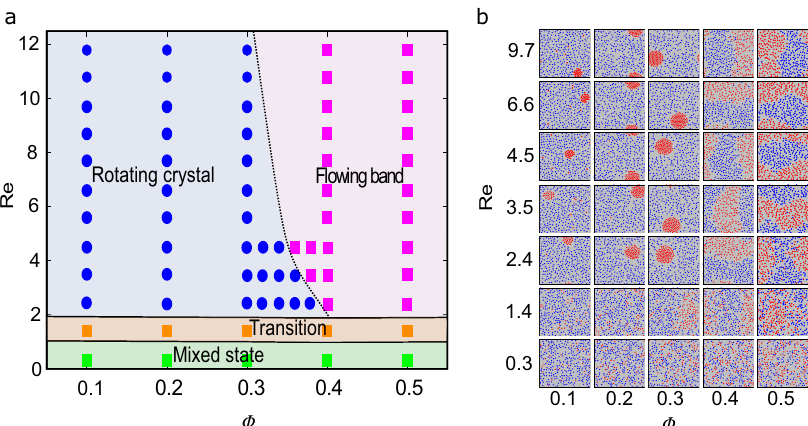
Fig. 1 Overall phase behaviours of mixtures of oppositely rotating disks. a State diagram of the mixtures having the total area fraction = 0.157 as a function of Φ and Re. The colours of the symbols and regions correspond to the labelled physical states. b The particle con fi gurations observed in the fi nal state of our simulations. Red and blue particles represent counter-clockwise (CCW) and clockwise(CW)